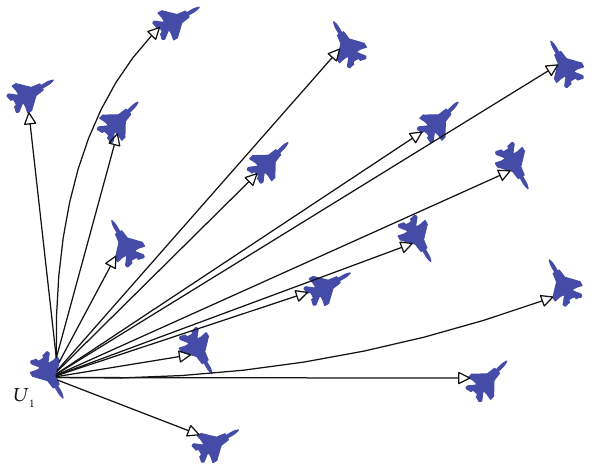
Figure 2: The communication mode in the consensus process in the baseline CBBA algorithm.